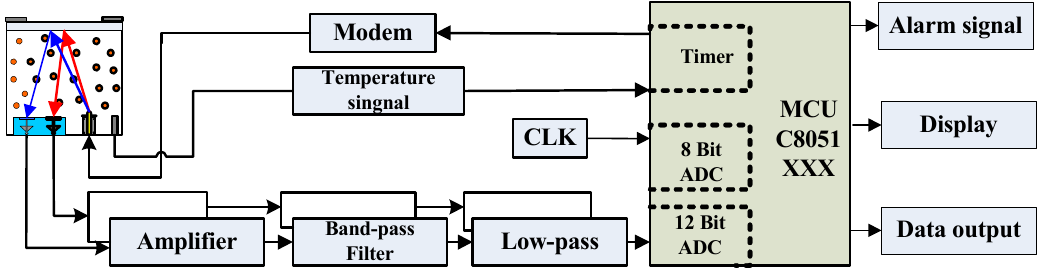
Figure 6. Schematic diagram of the detection system.